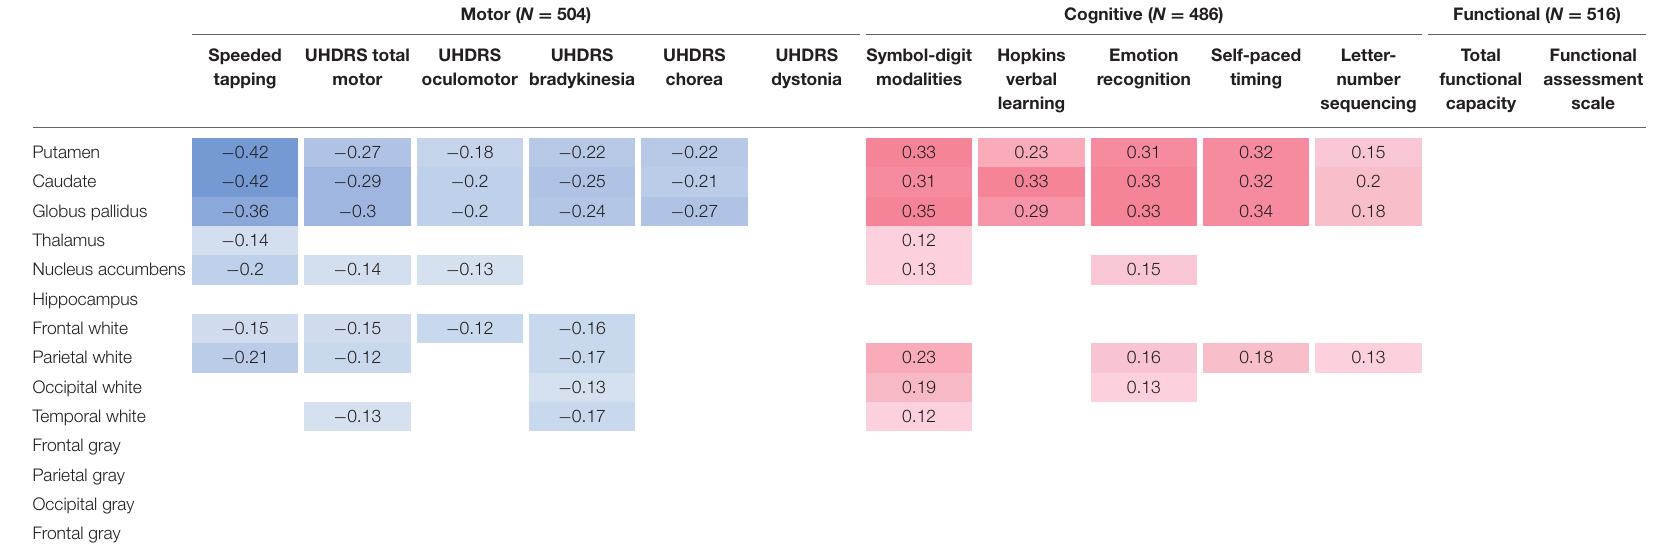
TABLE 1 | Cross-sectional partial correlations between regional brain volumes and clinical outcome measures in individuals prior to clinical motor diagnosis, after removing the effect of age, sex, and years of education, obtained from an analysis of the PREDICT-HD study (39). Motor ( N =